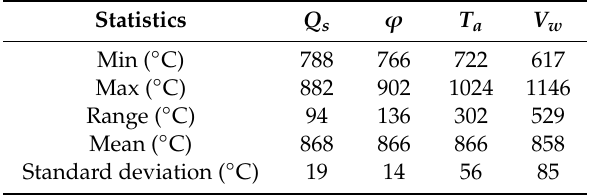
Figure 2. Ampacity due to variation of individual weather parameters. Table 3. Statistics of ampacity due to variation of individual weather